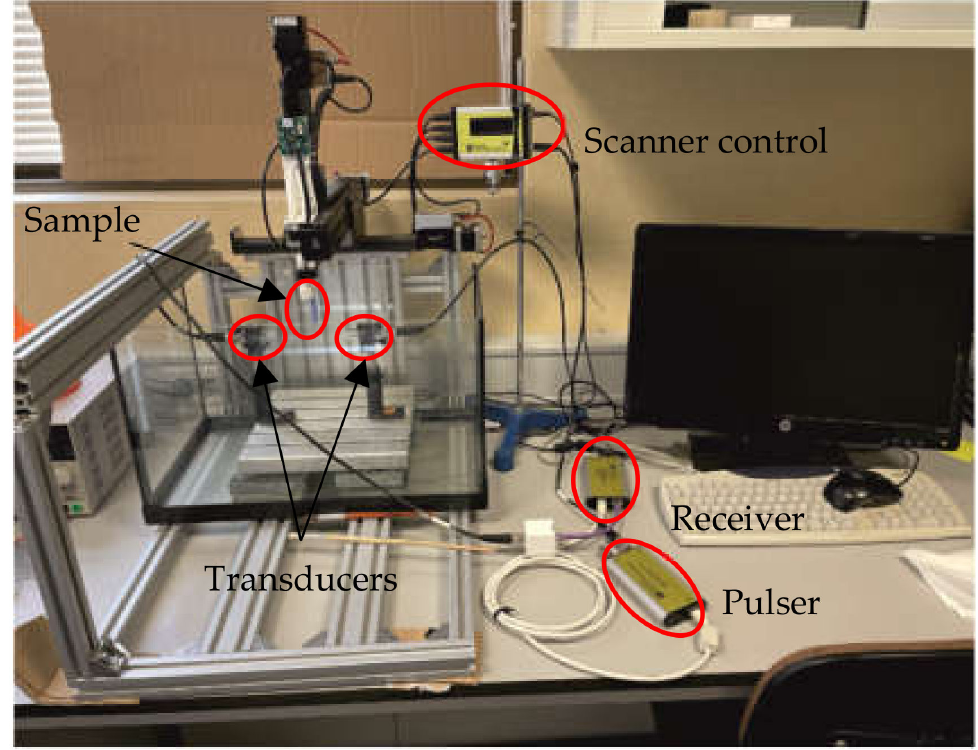
Figure 4. Experimental setup for ultrasonic